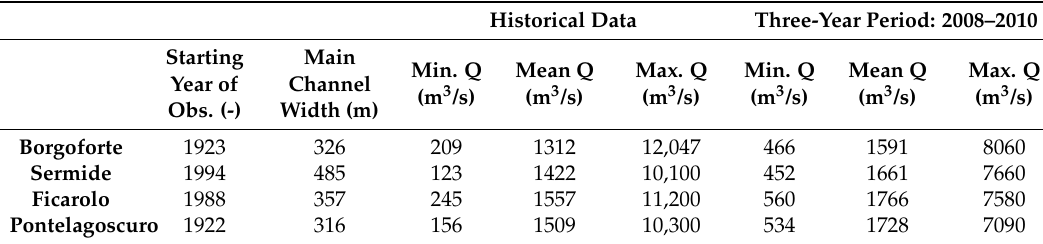
Figure 2. Flow hydrograph at the gauging station of ( a ) Borgoforte and ( b ) Sermide (blue lines) in the period 2008–2010: vertical lines represent an example of the timing of the SWOT overpasses during a short period (see Section 2.2 for details). Table 1. Hydrological statistics available at the gauging stations of interest.